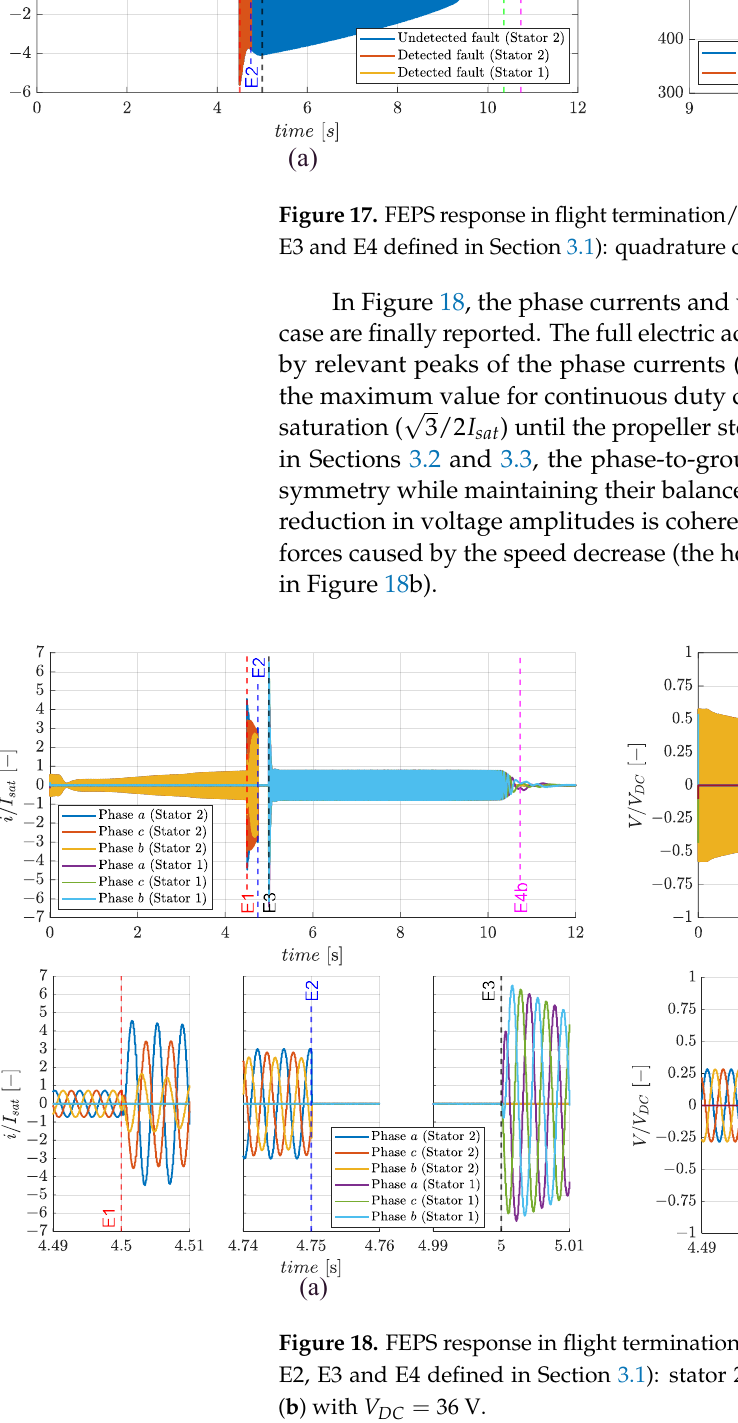
Figure 16. FEPS response in flight termination/landing with phase-to-ground fault on stator 2 (E1, E2, E3 and E4 defined in Section 3.1): propeller speed ( a ), propeller angle ( b ).